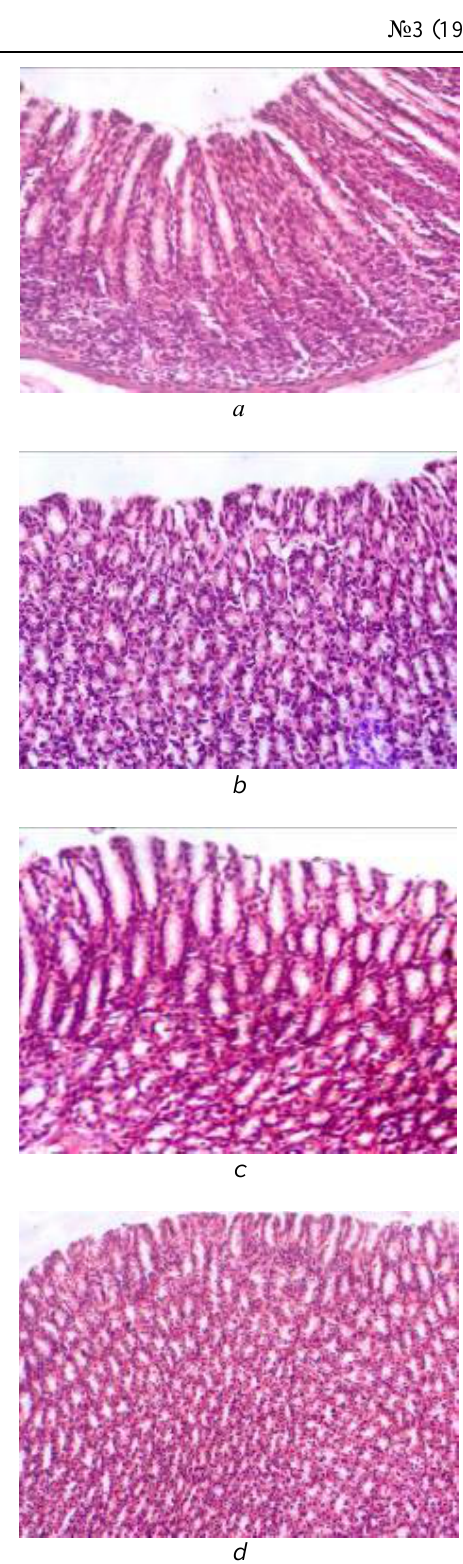
Fig. 11. The stomach of rats injected with dry cabbage extract at a dose of: a – 30 mg/kg; b – 40 mg/kg; c – 50 mg/kg; d – 60 mg/kg on the background of an alcohol-prednisolone mixture. The normal state of differ- ent parts of the mucous membrane: pyloric (a), prepylo- ric (b), fundal (d). Haematoxylin-eosin.